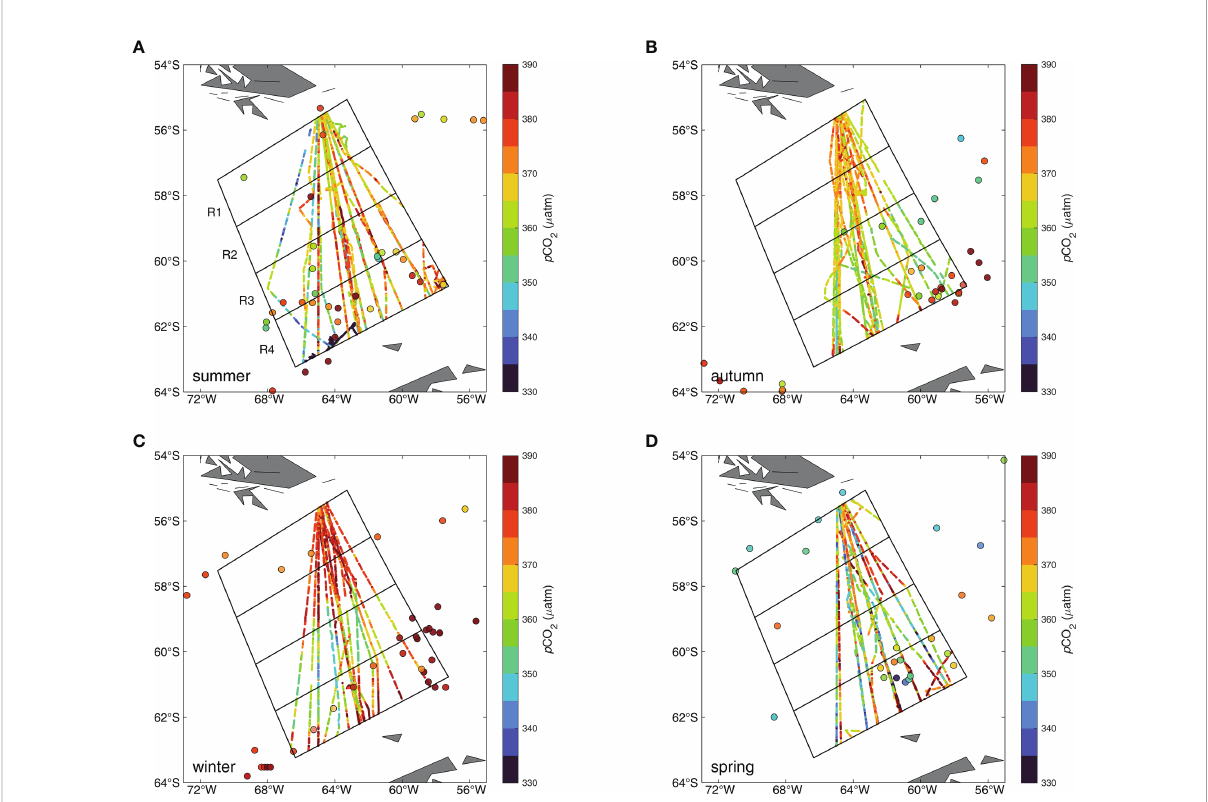
FIGURE 4 The spatial distribution of ship-based and fl oat-based p CO 2 in each season in the surface Drake Passage. (A – D) spring to winter. p CO 2 was normalized to year